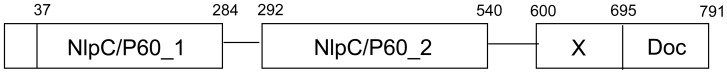
Schematic representation of the modular structure of RflaF_05439.The protein contains a signal peptide followed by two modules, predicted to belong to the NlpC/P60 superfamily (NlpC/P60_ 1 and NlpC/P60_ 2) and an X-dockerin (XDoc) modular dyad.